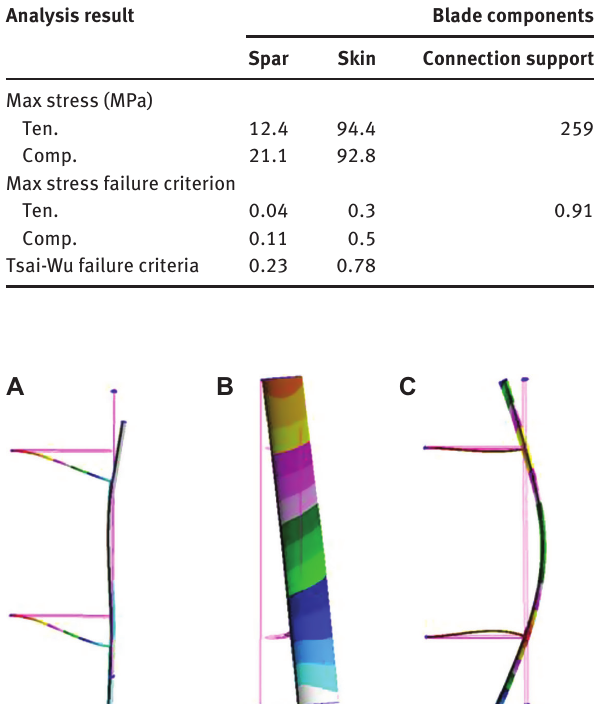
Table 5 Stress analysis results of small VAWT blade. Analysis